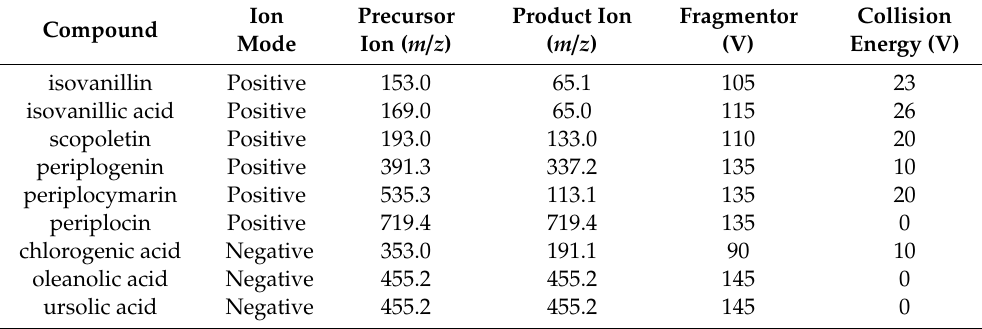
Table 8. Mass spectrometry parameters of nine target